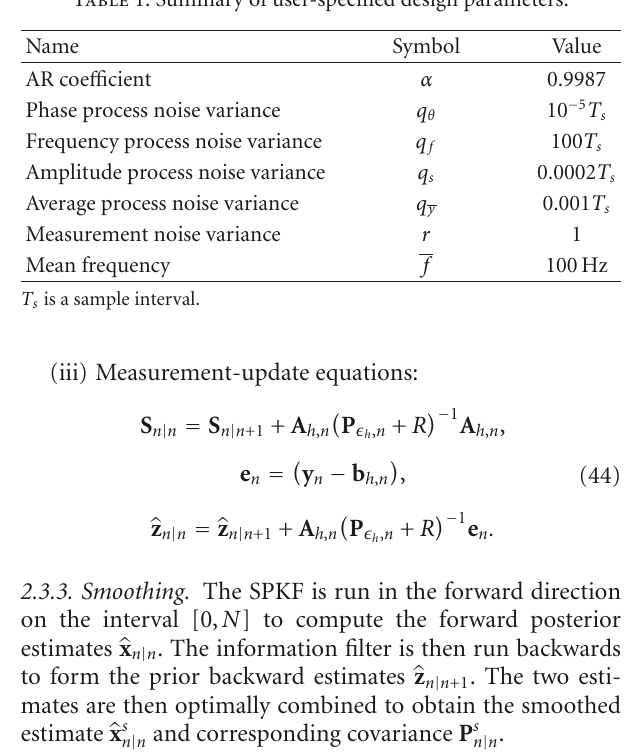
Table 1: Summary of user-specified design